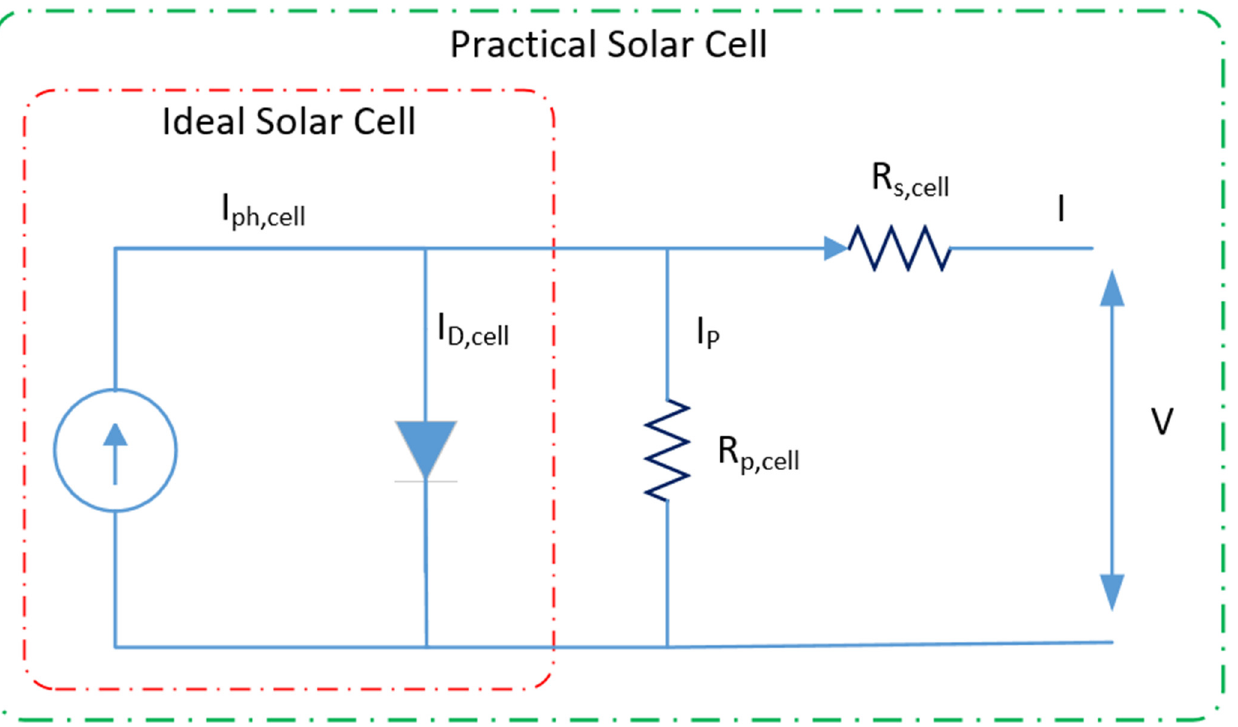
Figure 2. The circuit of a photovoltaic cell based on a single-diode mode. The solar cell model is ideal if the parallel and series resistance of the solar cell are not taken into account. Figure 3 illustrates the ideal electrical current and voltage curves from Equation (1) [32]. Table 2 shows the electrical parameters of the SPR-305 E-WHT-D photovoltaic cell [32].